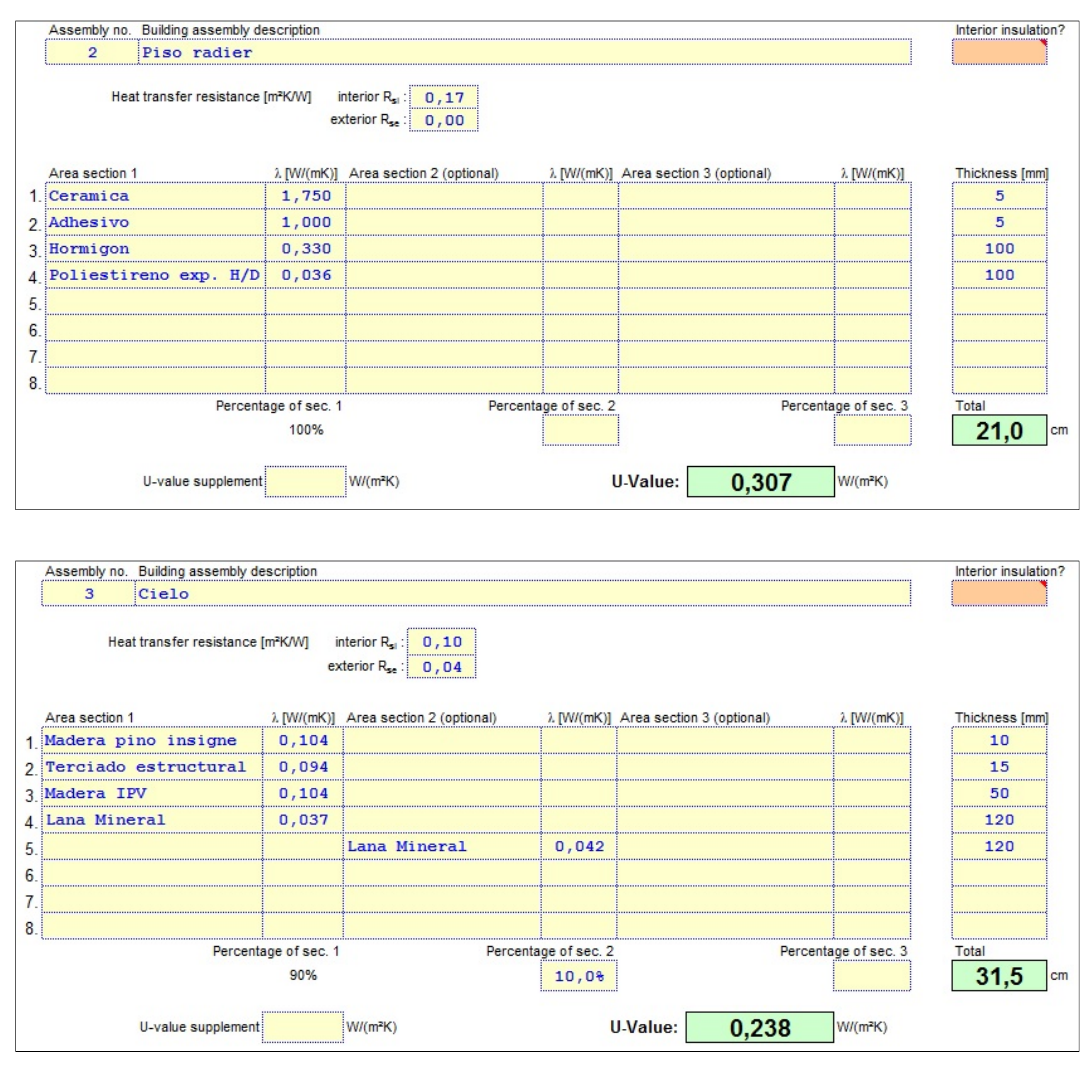
Figure A3. U Values.